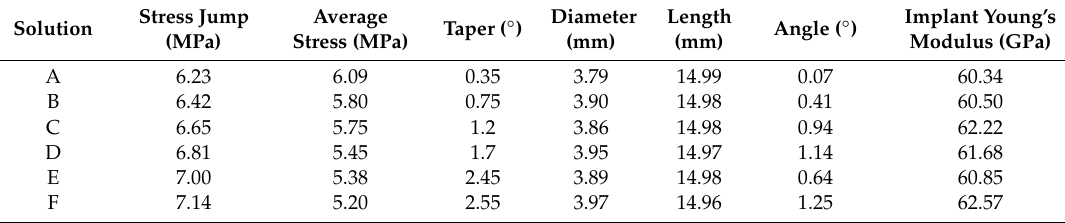
Figure 7. Solutions of genetic optimization: minimization of Response 1 and Response 2. Table 4. Optimal solutions for multi-objective optimization.